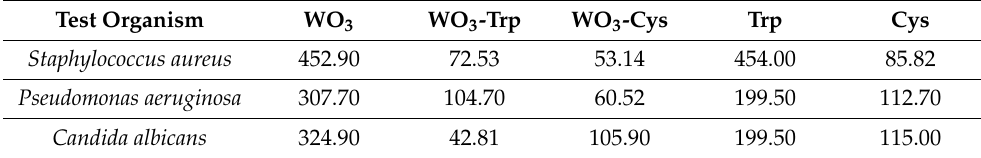
Table 1. The antimicrobial activity (MIC values) of the modified WO 3 -Cys and WO 3 -Trp NPs against three pathogenic microorganisms in comparison with WO 3 NPs and free amino acids (Cys and Trp). Test Organism WO 3 WO 3